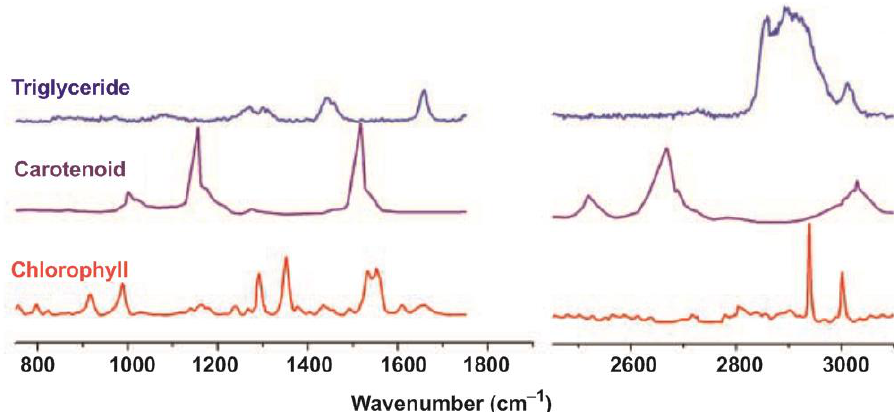
Figure 8. The Raman spectrum of carotenoid [132], chlorophyll [129], and triglyceride and the mean spectra acquired for starved C. sorokiniana and starved N. oleoabundans in the wavenumber regions of 750 – 1750 cm −1 and 2450 – 3150 cm −1 . Modified from Shutova et al. [134].